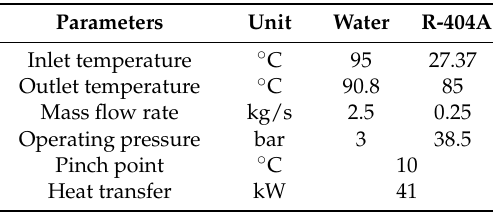
Table 2. Nominal input parameters and resulting